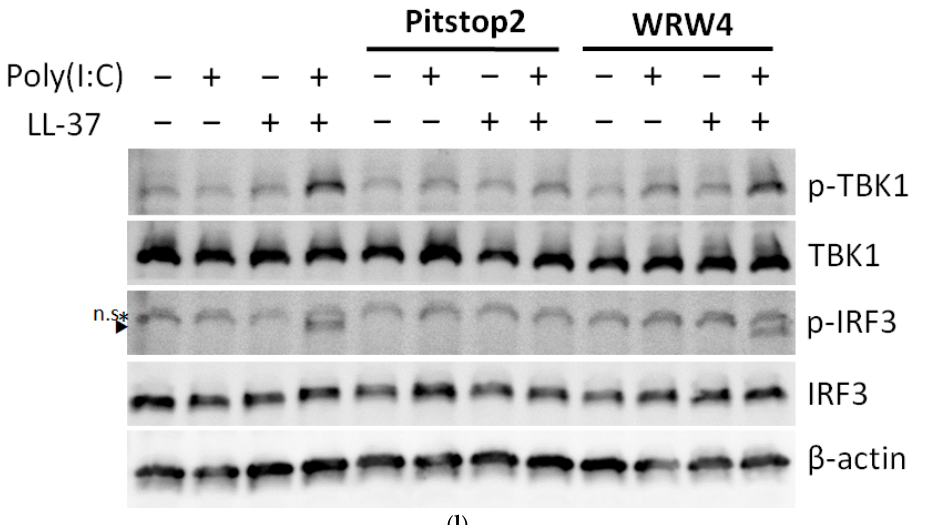
Figure 4. Co-stimulation of LL-37 and poly(I:C) in NHEKs induced various cytokines via clathrin- dependent endocytosis. NHEKs were pretreated with Baf-A1 (an inhibitor of endosomal receptors including TLR3) for 1 h or Pitstop 2 (a clathrin-dependent endocytosis inhibitor) for 30 min, then stimulated with LL-37 and poly(I:C) alone or in combination. Relative mRNA expressions of ( a ) CXCL10 , ( b ) IFNB1 , ( c ) TNFA , ( d ) DDX58 , ( e ) PTGS2 , and ( f ) VEGFA were quantified by RT-PCR. NHEKs were stimulated under the same conditions, and the protein levels of ( g ) CXCL-10 and ( h ) TNF- α in culture supernatants were analyzed by ELISA. NHEKs were transfected with siRNAs of TLR3, MAVS, or a combination of TLR3 and MAVS, and stimulated with LL-37 and poly(I:C) 2 days later. Relative mRNA expressions of ( i ) CXCL10 , ( j ) IFNB1, and ( k ) TNFA were quantified by RT-PCR. ( l ) NHEKs were pretreated with Pitstop 2 or WRW4 (an FPR2 inhibitor) and stimulated with poly(I:C) and LL-37, and 2 h later the cells were collected. Protein levels of p-IRF3, IRF3, p-TBK1, and TBK1 were evaluated by immunoblotting. β -actin was used as a loading control. Data are means ± SEM of three biological replicates. NS, p > 0.05, * p ≤ 0.05, ** p ≤ 0.01, *** p ≤ 0.001, **** p ≤ 0.0001 by